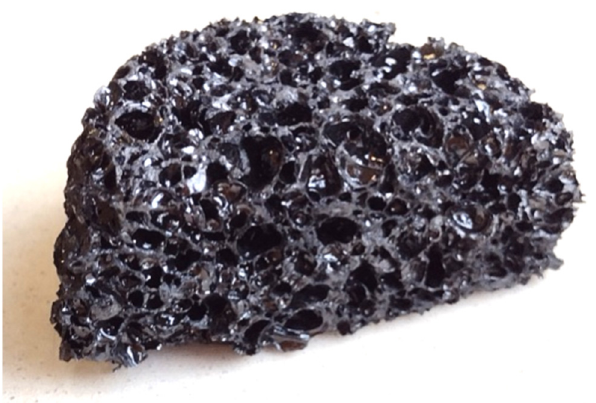
Figure 3. Coke recyclate used for the test specimens.